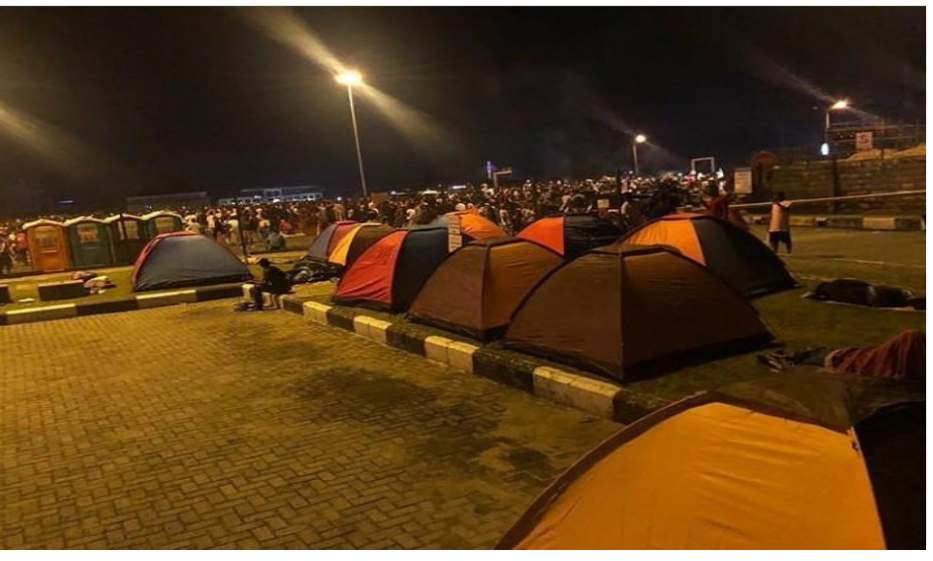
Figure 6: #EndSARS protesters camping at the Lekki tollgate; Source: Ajayi,